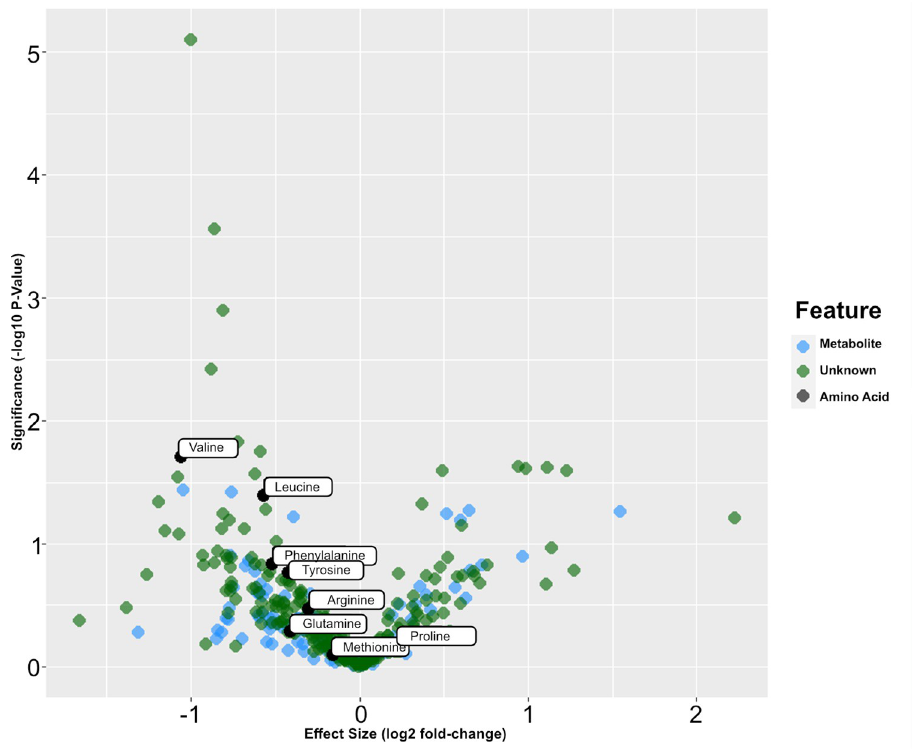
Fig 3. Volcano plot of statistical significance versus effect size for MS/MS validated features identified in the patient samples.